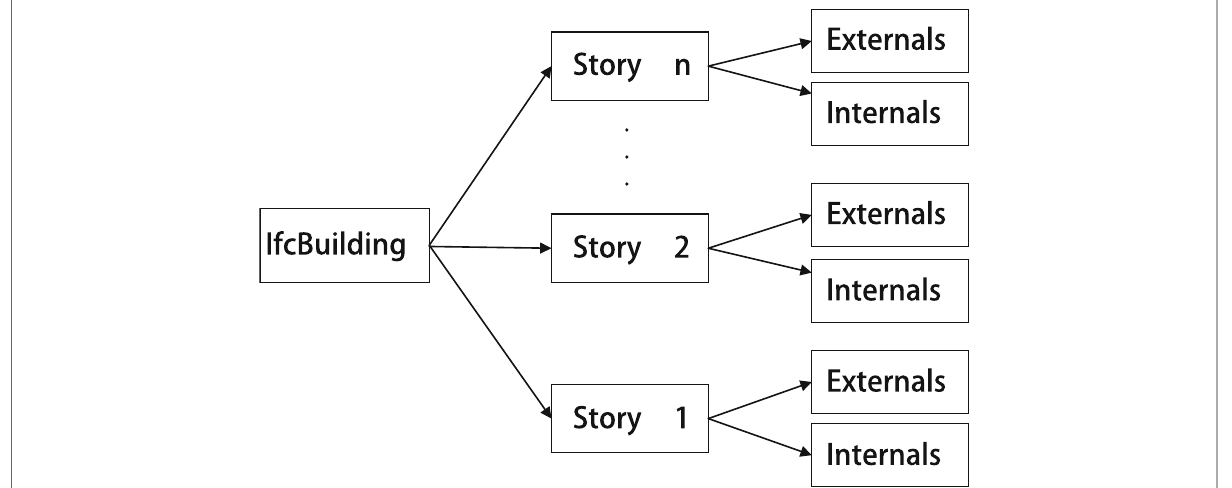
Fig. 5 Illustration of the entity IfcBuilding divided by the stories